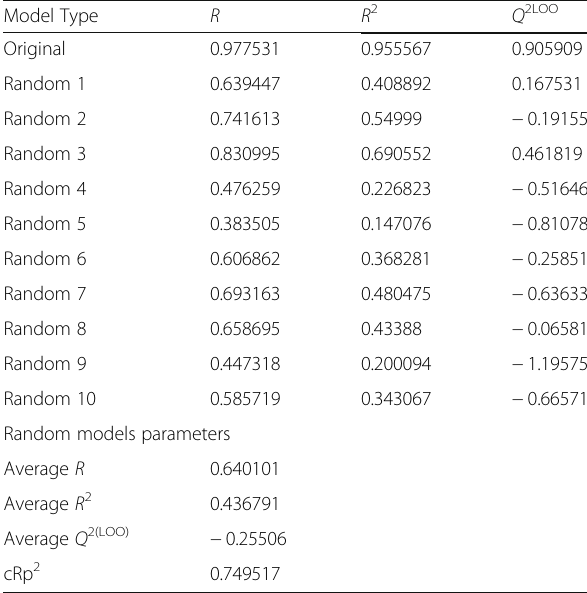
Table 8 Y-scrambling test parameters